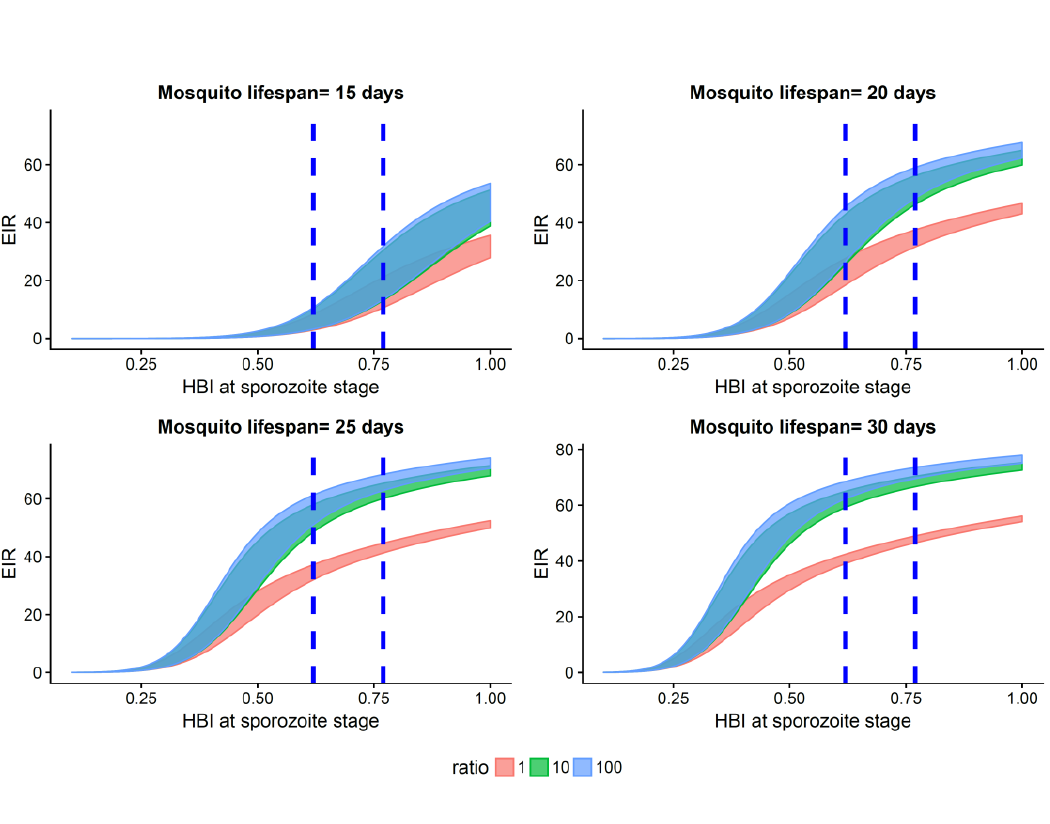
Figure 4 . Expected epidemiological consequences of HBI variation for different values of mosquito lifespan and mosquito/human ratio. The X axis represents the range of values considered for the HBI of infectious (sporozoite-infected) mosquitoes and the Y axis is the Entomological Inoculation Rate (EIR, number of infectious bites received by a person over one year) when the HBI of exposed mosquitoes corresponds to the confidence intervals of the HBI of oocyst-infected mosquitoes that were experimentally measured in this study. The ribbons represent the possible EIR values for different HBI of sporozoite-infected mosquitoes according to the confidence interval of HBI in oocyst-infected mosquitoes (63.6% ± 5.7%) and for different values of the mosquito to human ratio. The dashed lines represents the average value measured for susceptible mosquitoes (0.62) and for sporozoite-infected mosquitoes (0.77). Ratio=adult mosquito/human